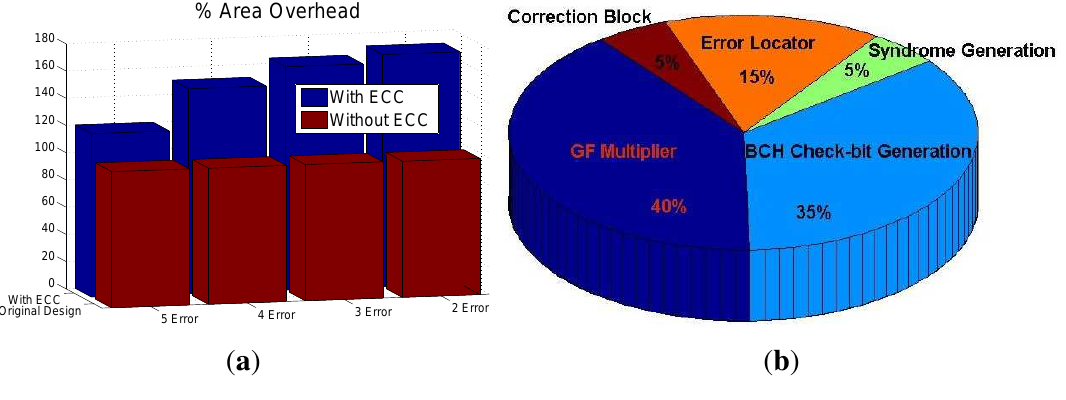
Figure 3. Area overhead analysis for comparative perspective. ( a ) Overhead analysis of BCH based error correction scheme; ( b ) Block wise area of a 45-bit GF multiplier with 3-bit error